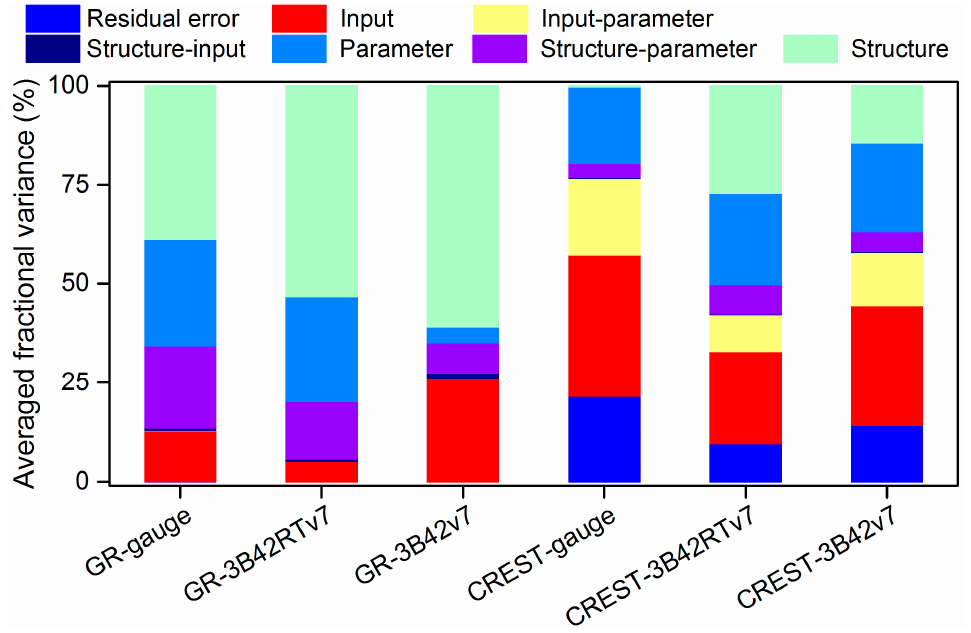
Figure 8. Stacked histogram of respective relative contribution of seven uncertainty components to the total uncertainty.